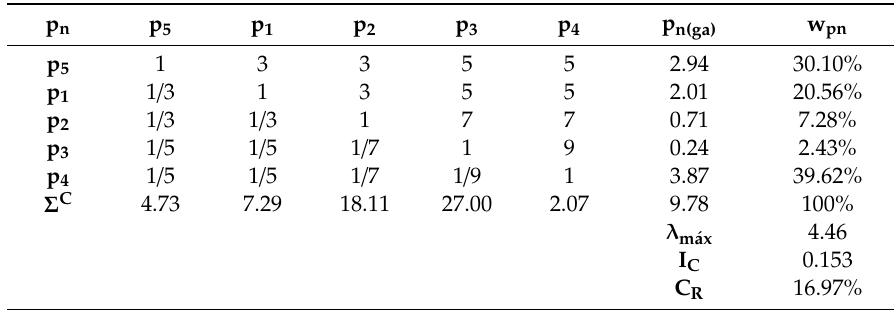
Table A5. To define the importance (weight) between the proprieties of contaminants—p n (criterial), I R = 0.90 (for n = 4).